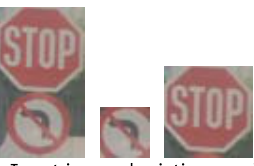
Figure 8. Left: Input image depicting overlapping signs, Middle: First extracted ROI, Right: Second extracted